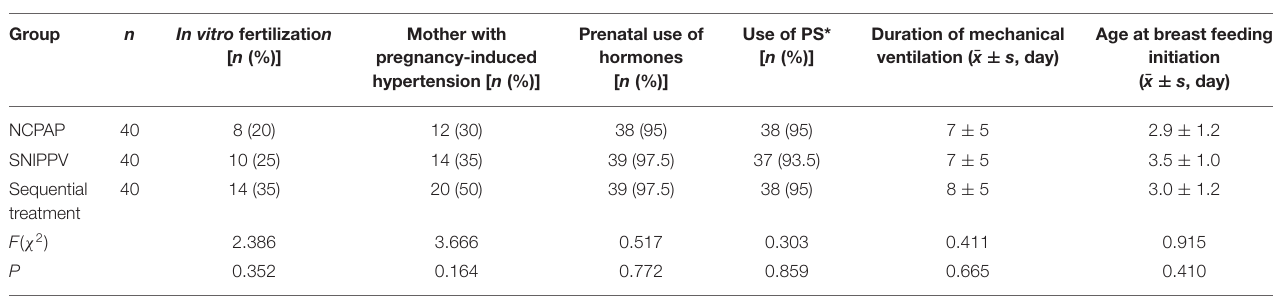
* PS, Pulmonary surfactants. P refers to three groups of comparison: NCPAP, SNIPPV and Sequetial treatment. The comparison was conducted among the three groups. If P < 0.05, a pairwise comparison was further performed between every two groups. If P > 0.05, it means that there was no statistical difference among them, so no further pairwise comparison would be